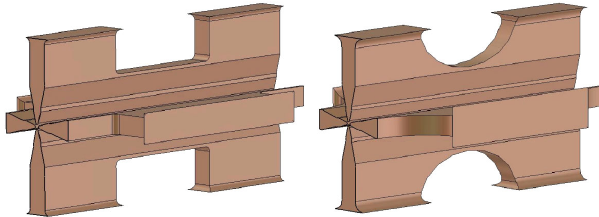
FIG. 11. Electric field comparison of two different window